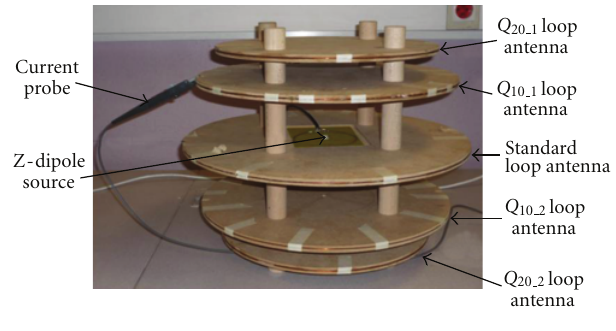
Figure 3: Prototype